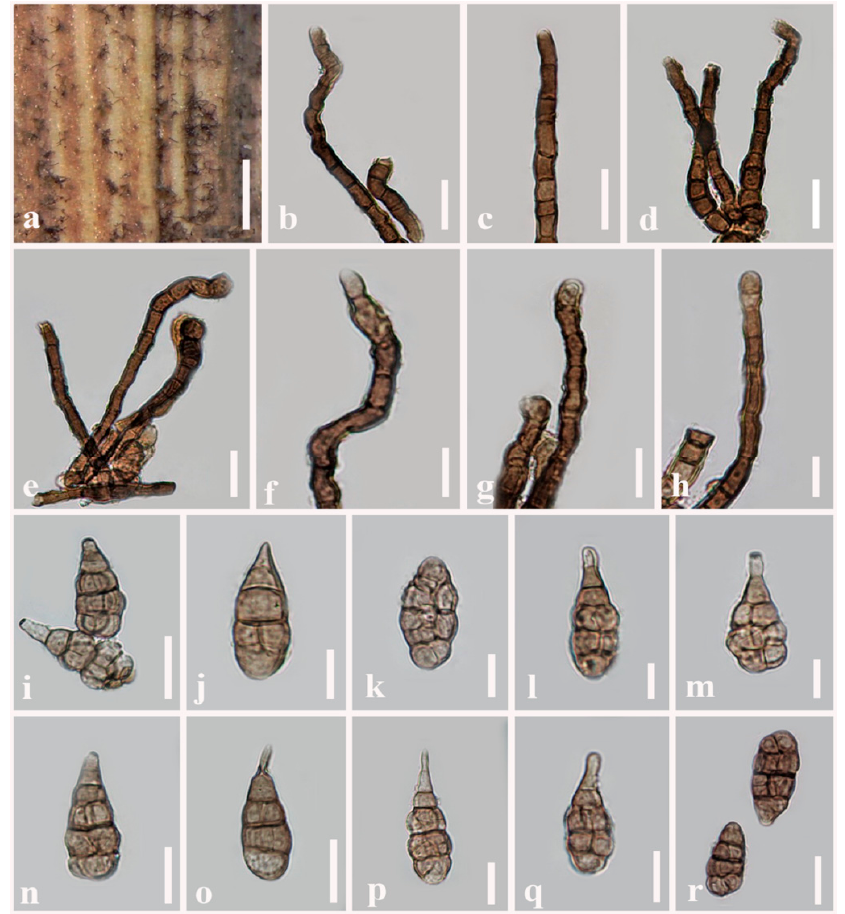
Figure 3. Alternaria obpyriconidia (MFLU 21-0300, holotype). ( a ) Colonies on dead stems of Vicia faba ; ( b – d ) Conidiophores; ( e – h ) Conidiophores bearing conidiogenous cells; ( i – r ) Conidia. Scale bars: ( a ) = 1000 µm, ( e ) = 50 µm, ( b – d , f – h , n – q ) = 30 µm, ( i – m , r ) = 20 µm. ( a ) = 1000 µ m, ( e ) = 50 µ m, ( b – d , f – h , n – q ) = 30 µ m, ( i – m , r ) = 20 µ